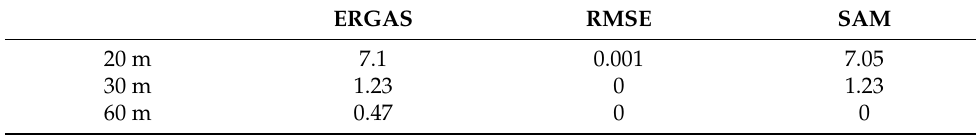
Table 4. ERGAS, RMSE and SAM